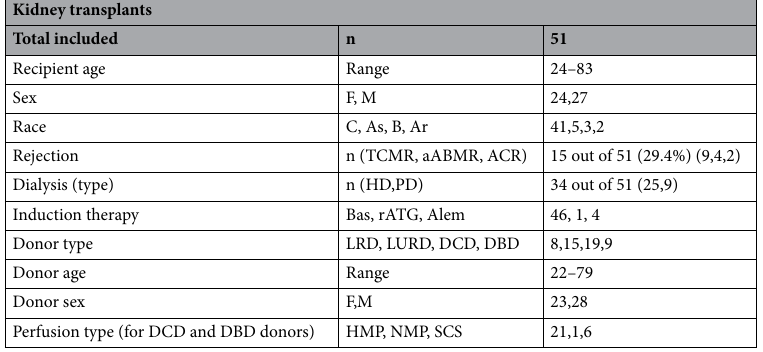
Table 1. Overview of recipient and donor characteristics. Recipients; median age and range, distribution of males and females, race ( C Caucasian, As Asian, B Black, Ar Arab), rejection type ( TCMR T cell-mediated rejection, aABMR acute antibody-mediated rejection, ACR borderline acute cellular rejection), dialysis type ( HD hemodialysis, PD peritoneal dialysis), and induction therapy ( Bax Basixilimab, Alem Alemtuzumab).